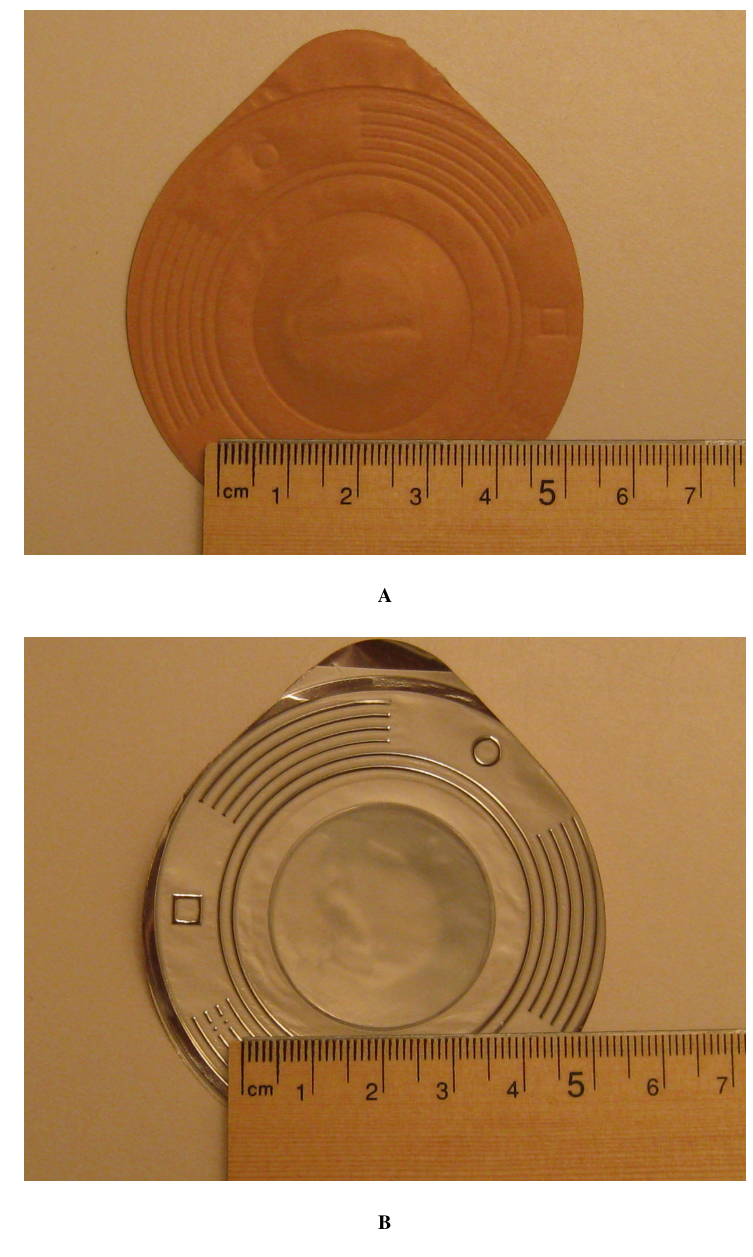
FIGURE 2. (A) Testosterone patch demonstrating the surface in contact with the skin with the delivery mechanism being the central area and the remainder being adhesive. (B) The reverse side of the patch is